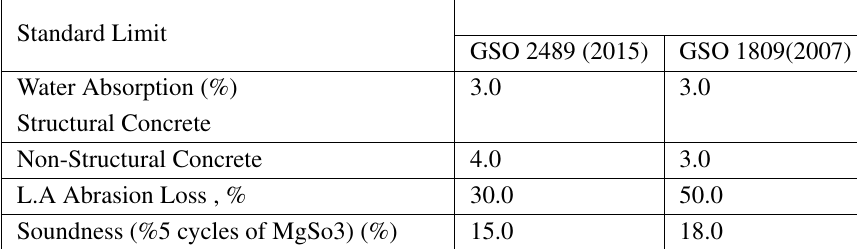
Table 9. Comparison of RA limits and virgin aggregate limits for concrete